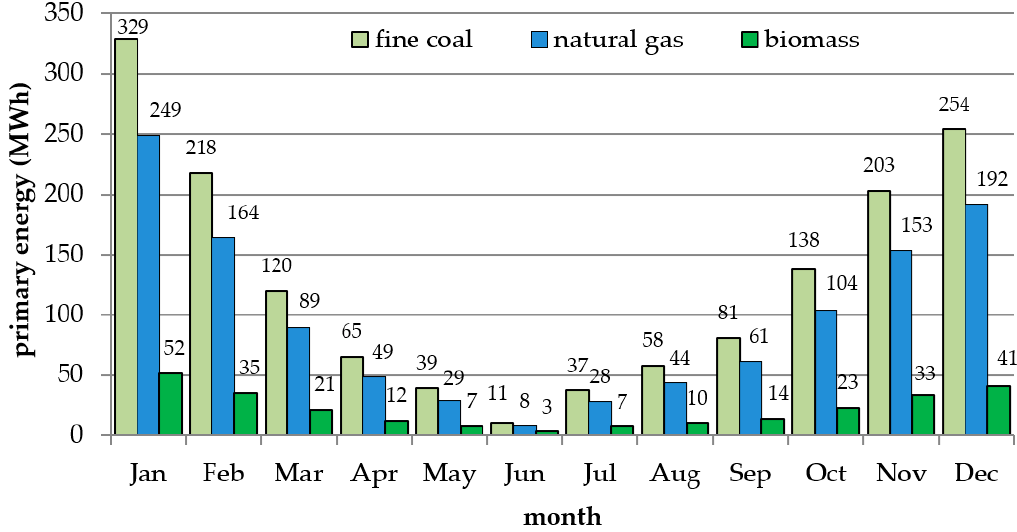
Figure 5. Monthly primary energy sums used for the purpose of GH heating.